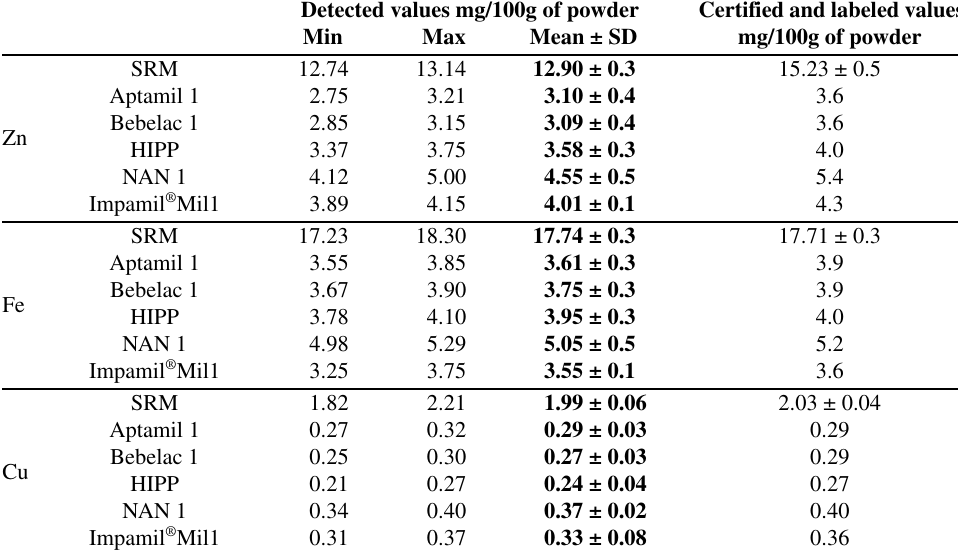
Table 7. Detected (by FAAS) and certified and labeled values of microelements in infant formula and SRM. Mini- mum and maximum values are expressed as mean values (n = 12) Detected values mg/100g of powder